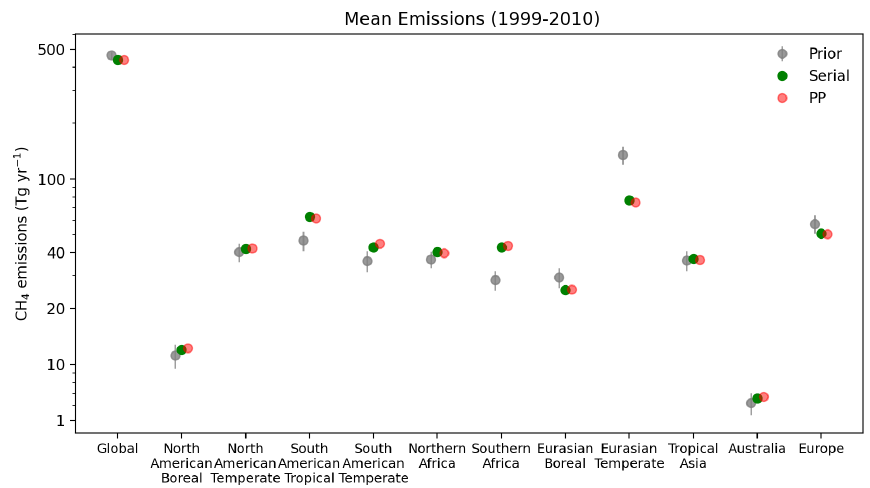
Figure 5. Total methane emission estimates from the inversions for the globe and TRANSCOM regions (see Fig. 2), averaged over 1999– 2010. The vertical lines on the markers show the ± 2 σ uncertainties of the prior emissions.